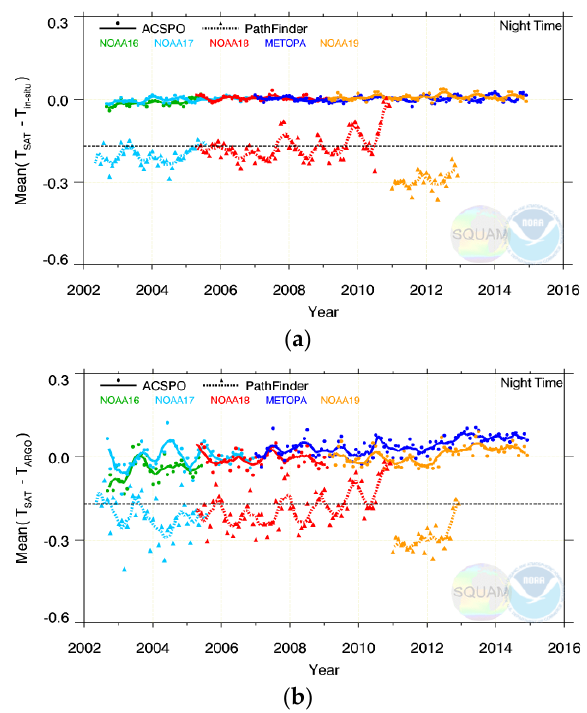
Figure 9. Monthly mean nighttime biases of Δ T S = T S − T in situ against ( a ) drifters plus /tropical moorings; and ( b ) ARGO floats. (RAN1 SSTs are SSES bias corrected.)